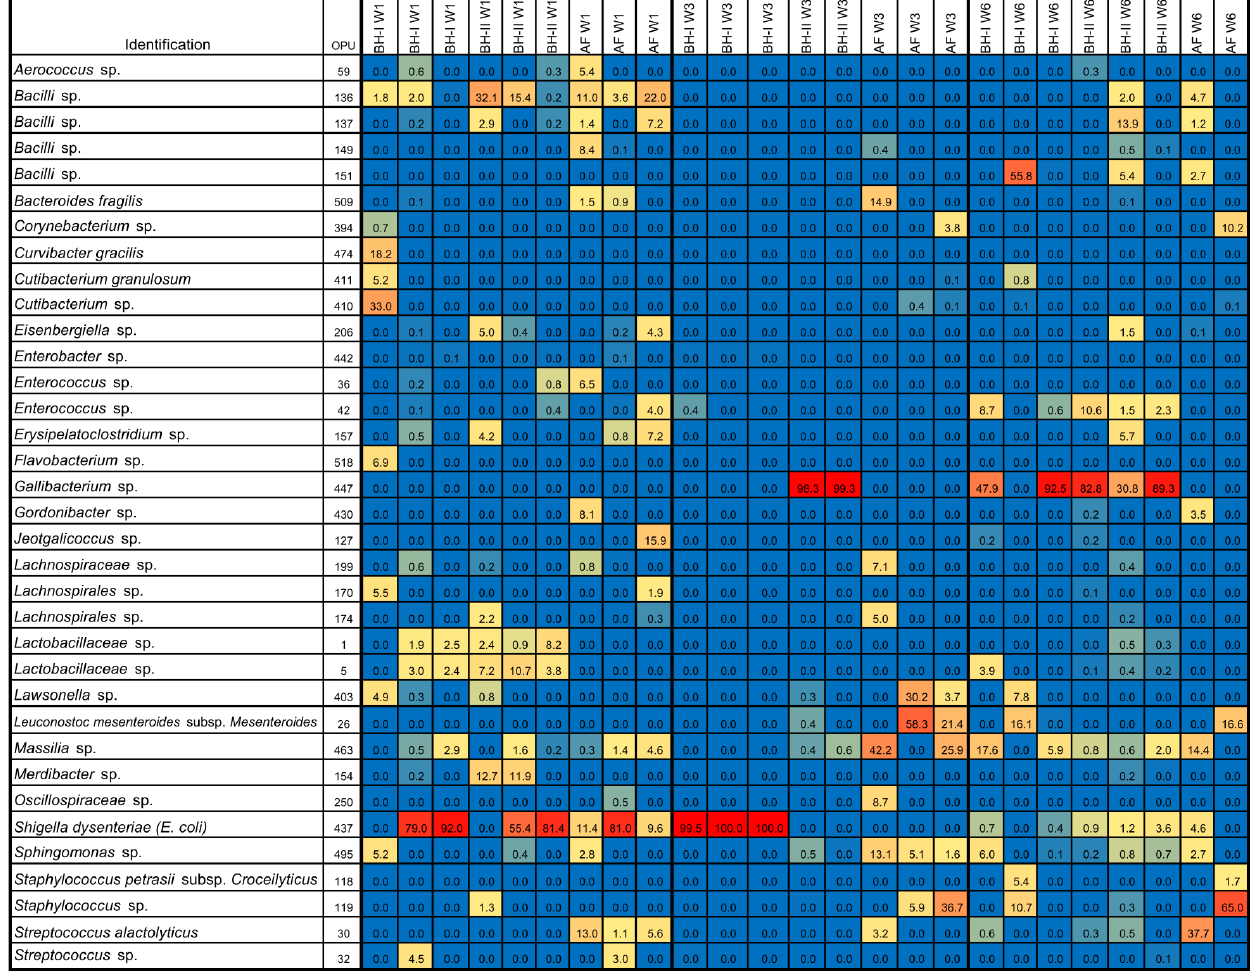
Figure 6. Heatmap of tracheal samples. Heatmap of relative abundances (%) of top OPUs per sample up to 5%. The inset color of blue indicates zero; yellow to increasing red values indicate above 1%. A list of OPUs and their closest relative sequence is given in Table S8. AF: experimental animal facility, BH: broiler house. W1: week 1, W3: week 3, W6: week